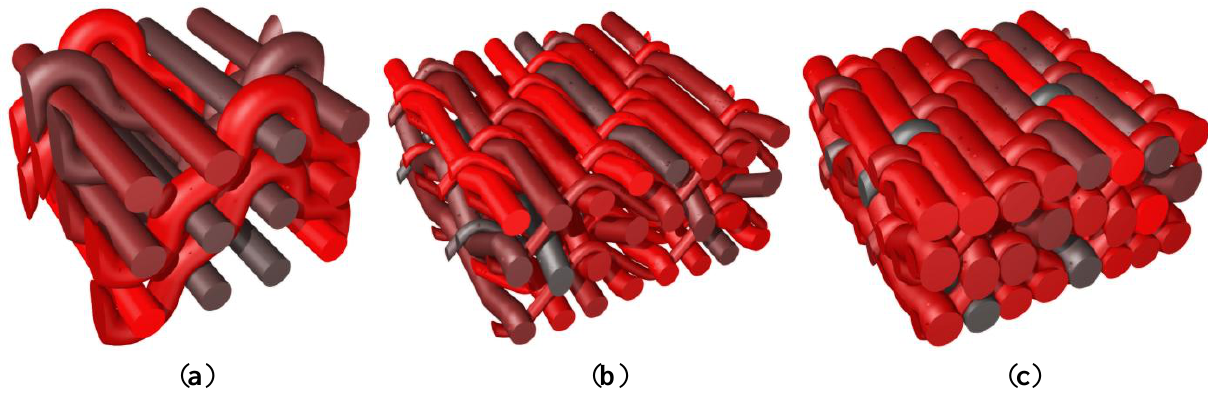
Figure 11. Woven composite with post-processing of the weave configuration to reach contact between yarns. ( a ) Weaving principle; ( b ) RVE before level set-based post-processing; and ( c ) RVE after level set-based